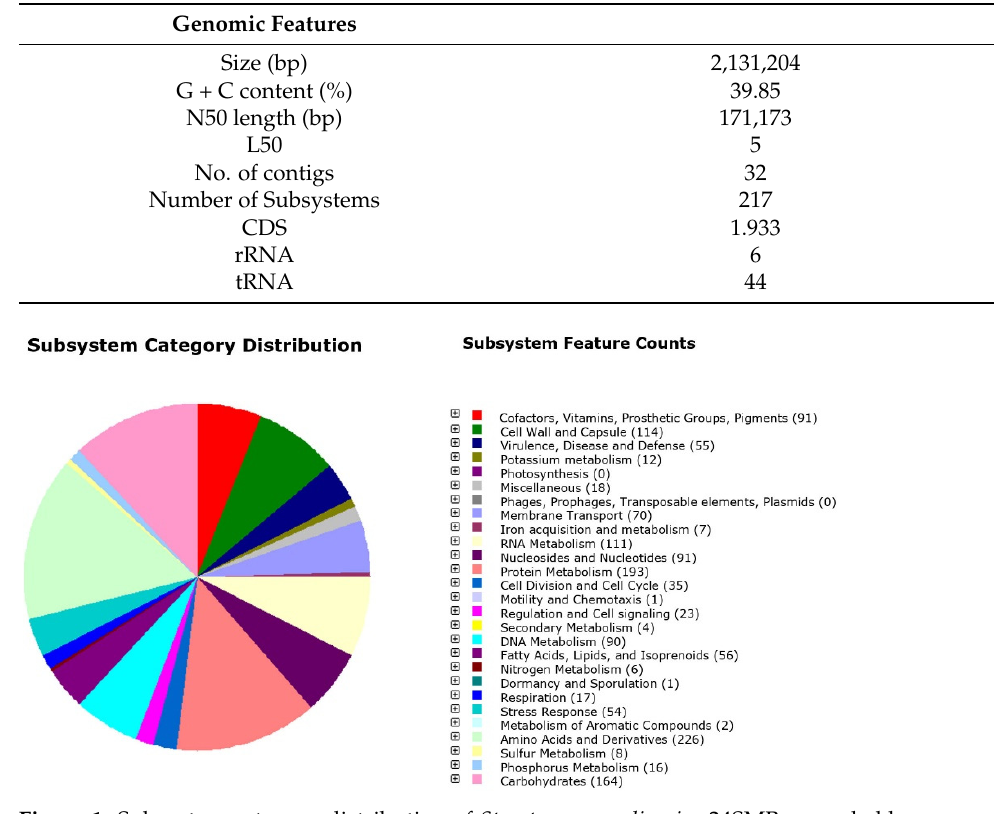
Table 1. Main features of the Streptococcus salivarius 24SMBc genome. N50 (value to assess the contiguity of assembly, by the length of the shortest contig at 50% of the total size of the assembly); L50 (the number of contigs at 50% of the total size of the assembly); CDS (coding sequence).